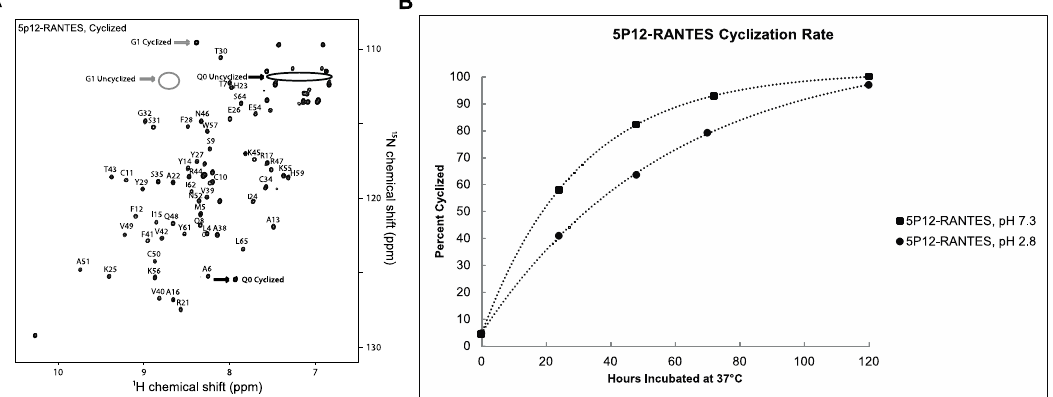
Figure 3. 5P12-RANTES cyclization. ( A ) HSQC spectrum of cyclized 15 N-labeled 5P12-RANTES after being incubated at 37 ◦ C for 5 days at pH 2.8. NMR was performed in 20 mM sodium phosphate at pH 2.8, 25 ◦ C. Cyclization results in a shift of the G1 residue (grey arrows; G1 resonances denoted by gray arrows and circles), as well as an appearance of the N-terminal pyroglutamate residue (black arrow; Q0 resonances denoted with black circles and arrows) as well as loss of Q0 amide side chain peaks (black arrow, circled). Assignments are not shown for certain areas as described in Figure 2. ( B ) Cyclization over time of 5P12-RANTES at pH = 7.3 and pH = 2.8, incubated at 37 ◦ C. Amount of cyclization was determined by obtaining peak heights of the amide of G1 when the N-terminus of the protein (Gln0) was cyclized and uncyclized using NMRPipe, and dividing the cyclized peak height by the total of all G1 (cyclized and uncyclized) peak heights.